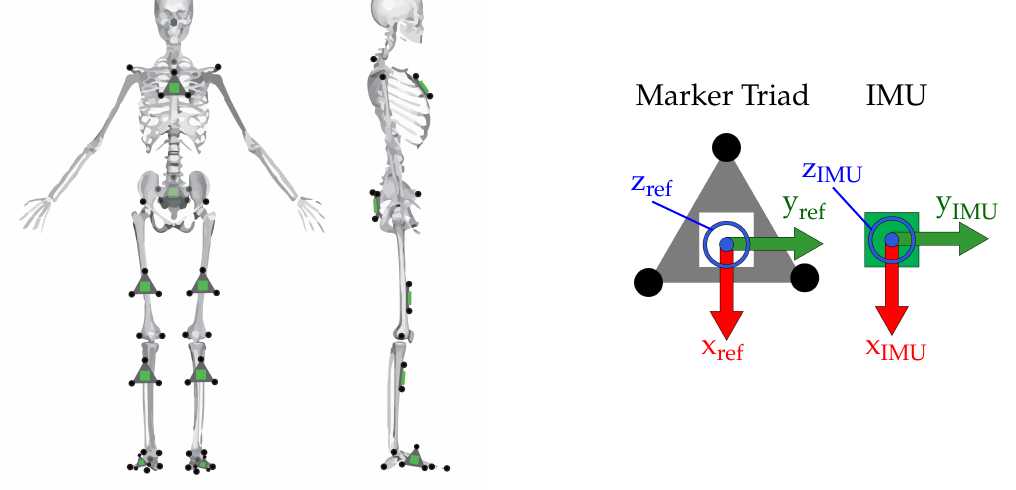
Figure 1. ( Left ) Placement of the reflective markers (black circles) and IMUs (green squares) on the subject. IMUs on the thigh and shank were not placed precisely, and location varied both vertically and in the transverse plane. ( Right ) A blown-up illustration of the marker triads with three markers affixed and IMU. Coordinate system of the IMU was known a priori, and the comparison reference coordinate system of the marker triad was constructed to match. Image from